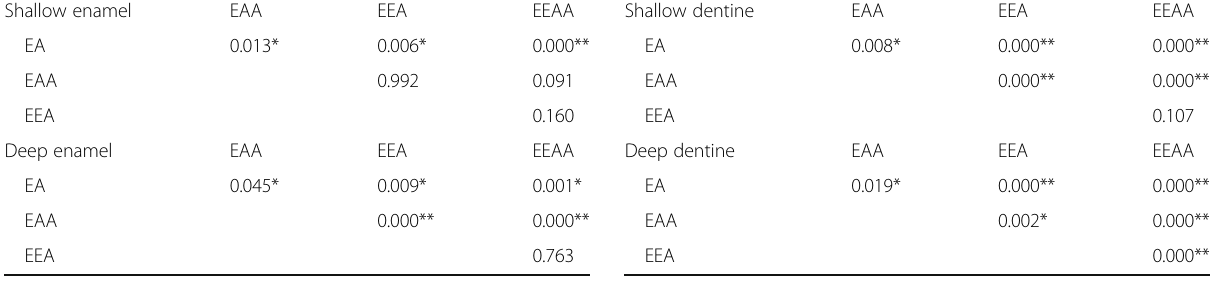
Table 4 Multiple comparisons for the mean Δ E (T2-T0) between the different resin infiltration protocols in the shallow and deep enamel groups Shallow enamel